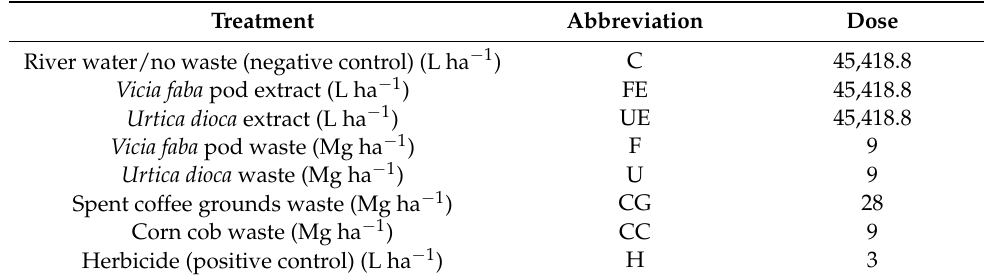
Table 2. Doses for treatments tested in Experiment